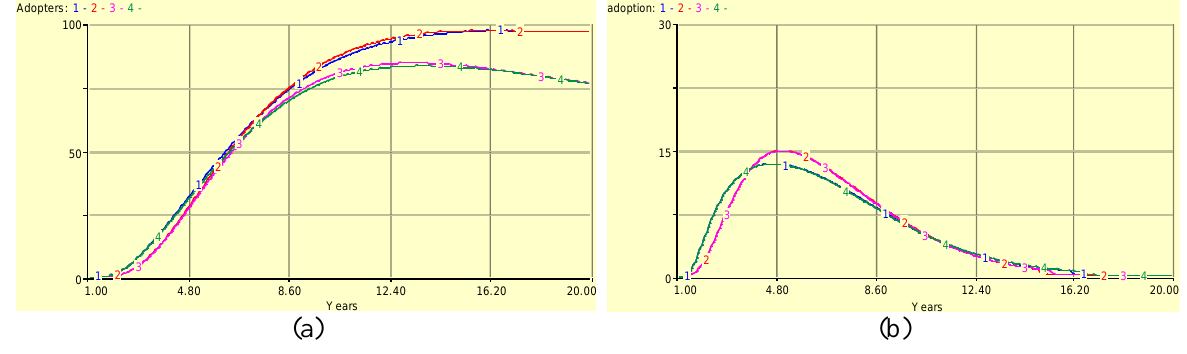
Fig. 6. Output behaviour for the scenario-based